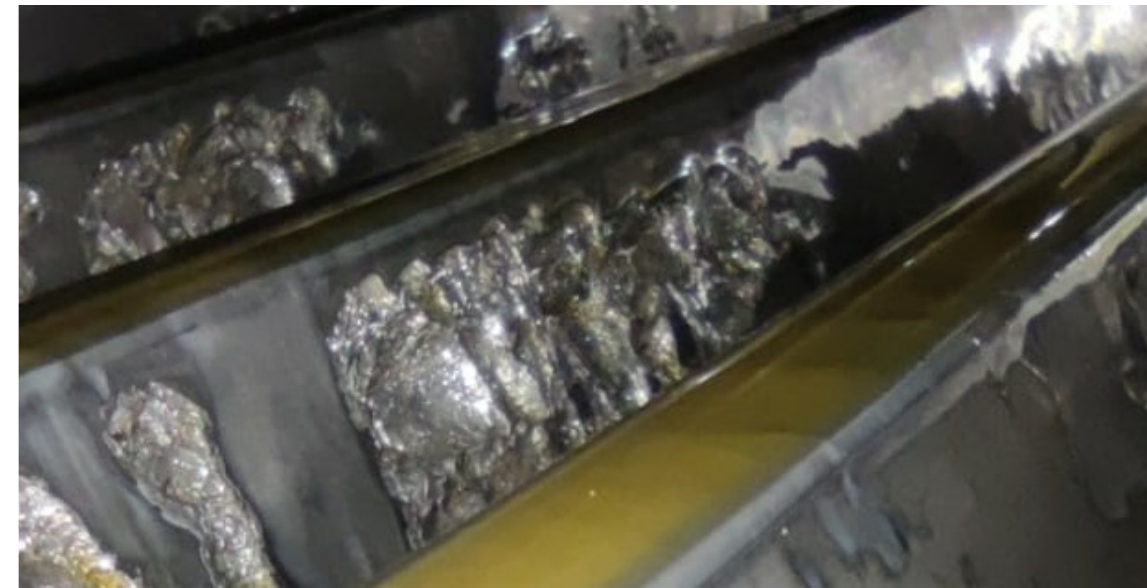
Figure 8. Spalling wear of gear wheels of the wind turbine planetary gear due to the cyclical impact of contact stresses.